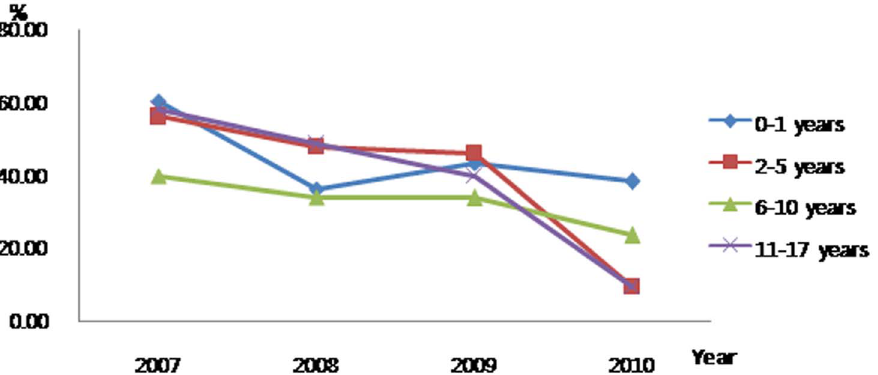
Figure 2. Trends for administering new chemotherapy as aggressive end-of-life care to Korean pediatric cancer patients who died